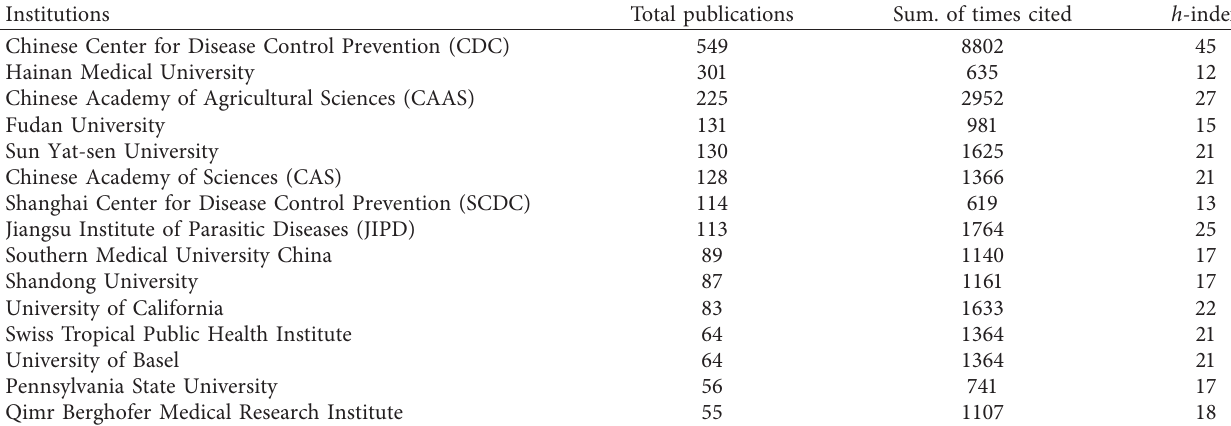
Table 1: The top 15 institutions with tropical medicine related publication and citations, 2010–2019.